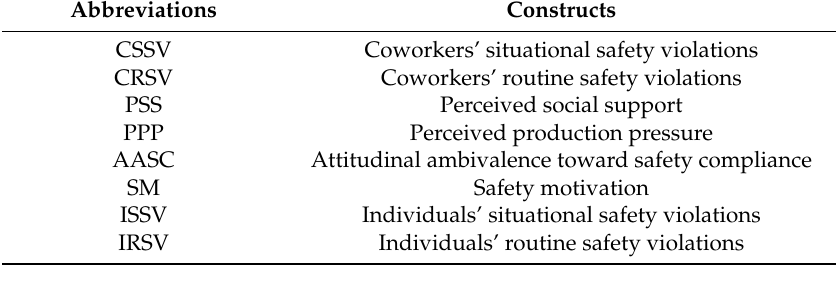
Table 2. Glossary of abbreviations.